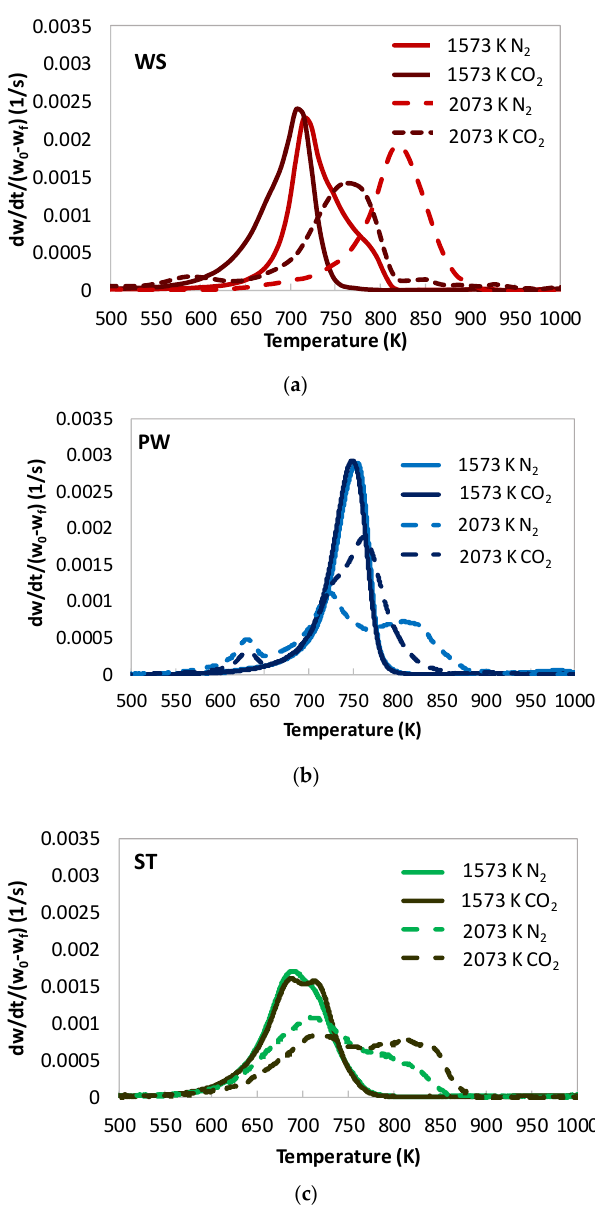
Figure 5. TGA combustion tests of char samples: ( a ) WS, ( b ) PW; ( c ) ST. Table 2. Results of combustion tests in TGA on raw biomass and Heated Strip Reactor (HSR) chars. Samples